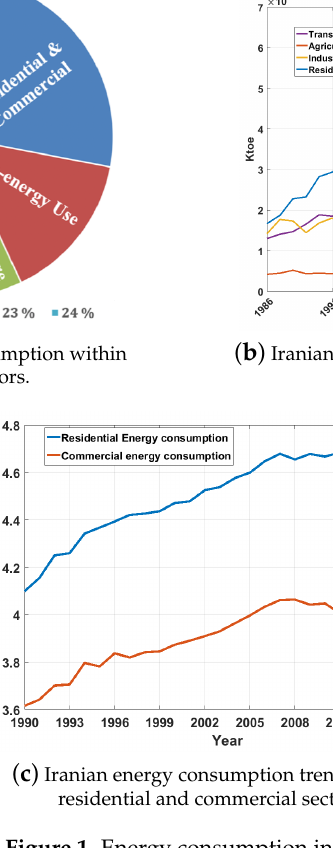
Figure 1. Energy consumption in Iran